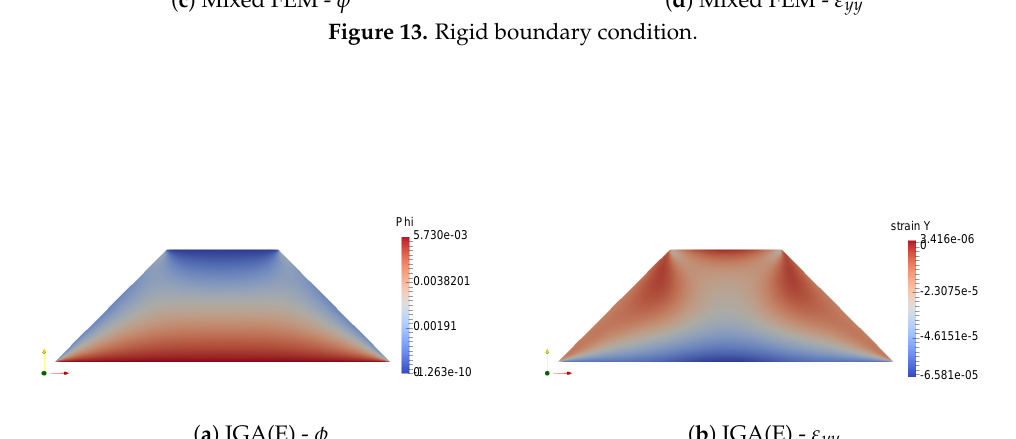
Figure 13. Rigid boundary condition.